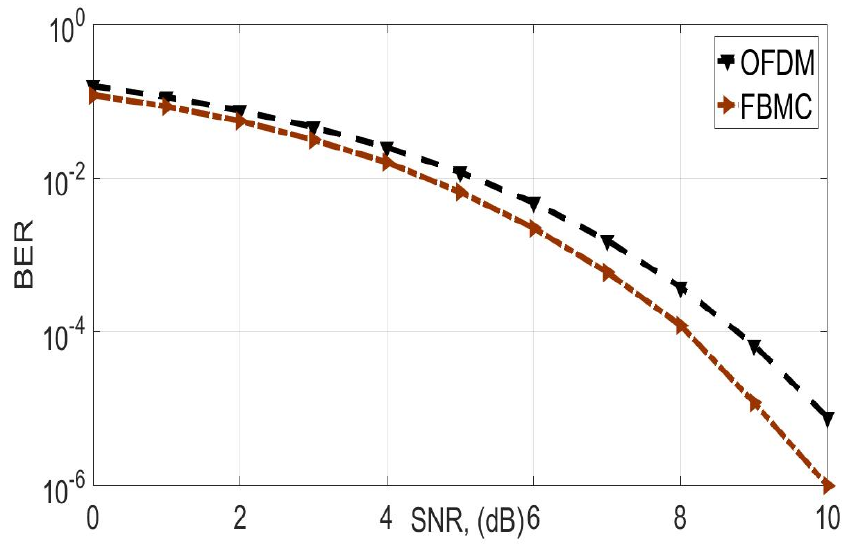
Figure 8. SNR Vs. BER.